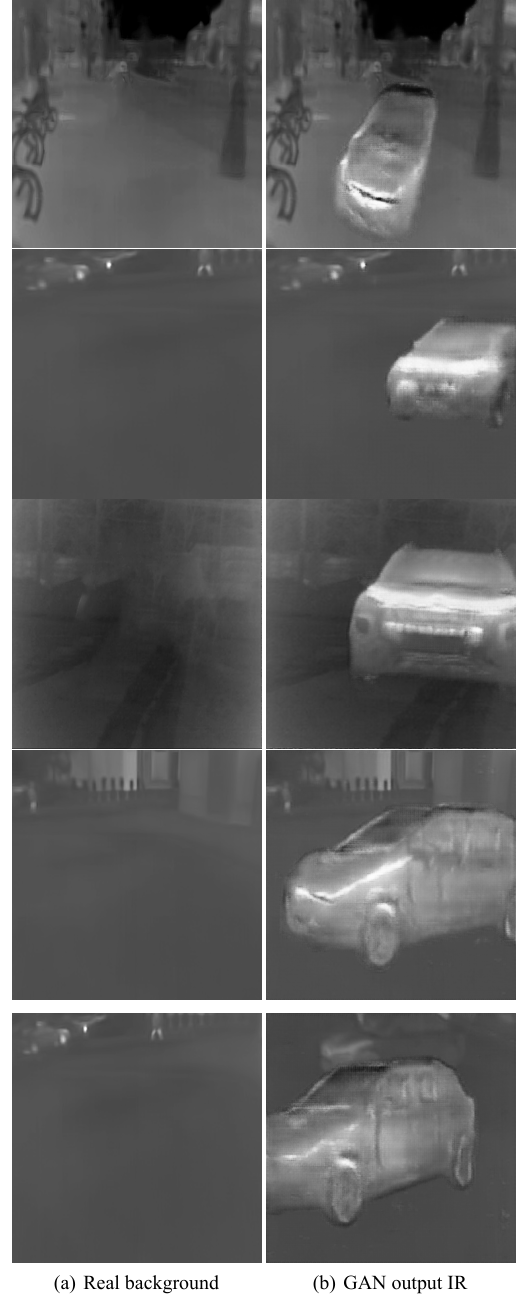
Figure 6. Examples of generated